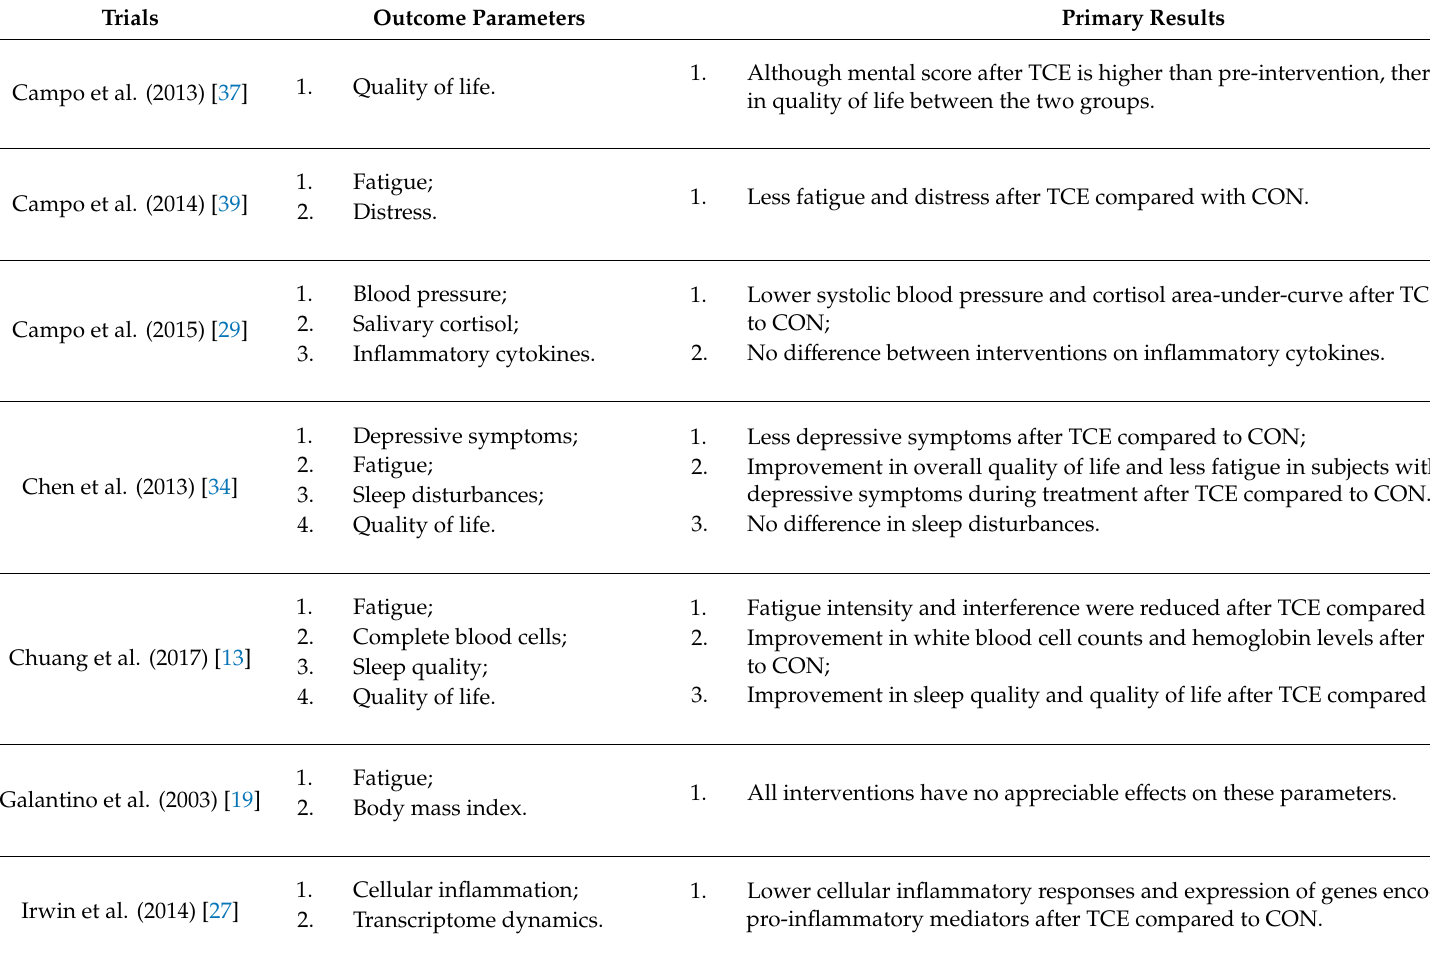
Table 3. The main results of included